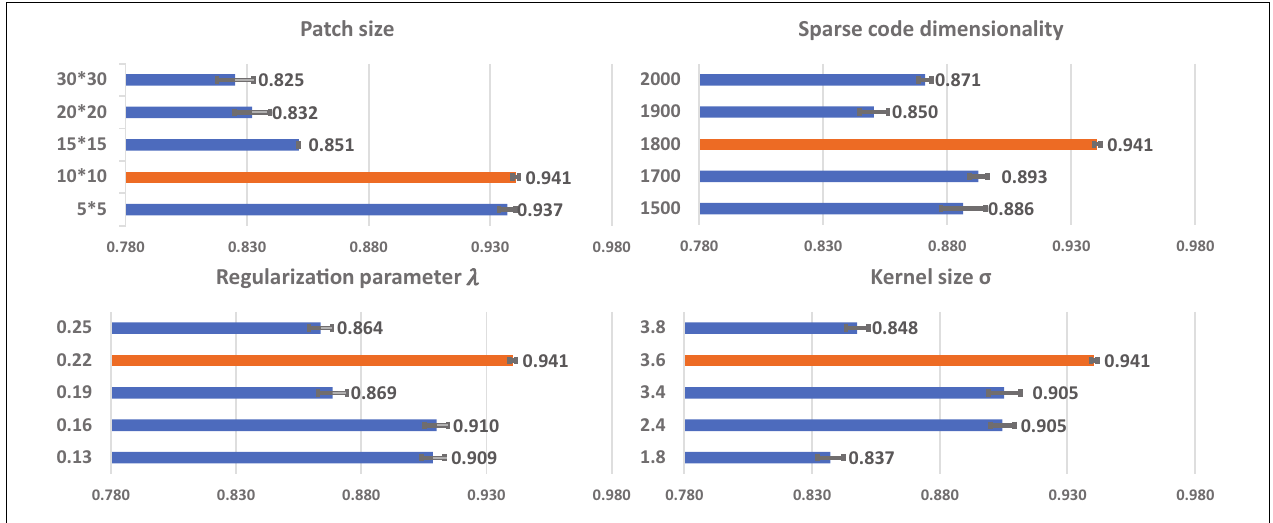
FIGURE 3 | The relationship of each parameter to classification accuracy. The y -axis represents the value for each parameter. The orange bars represent the classification performances using the optimal parameters. Each bar represents the average and 95% confidence interval of classification accuracy.